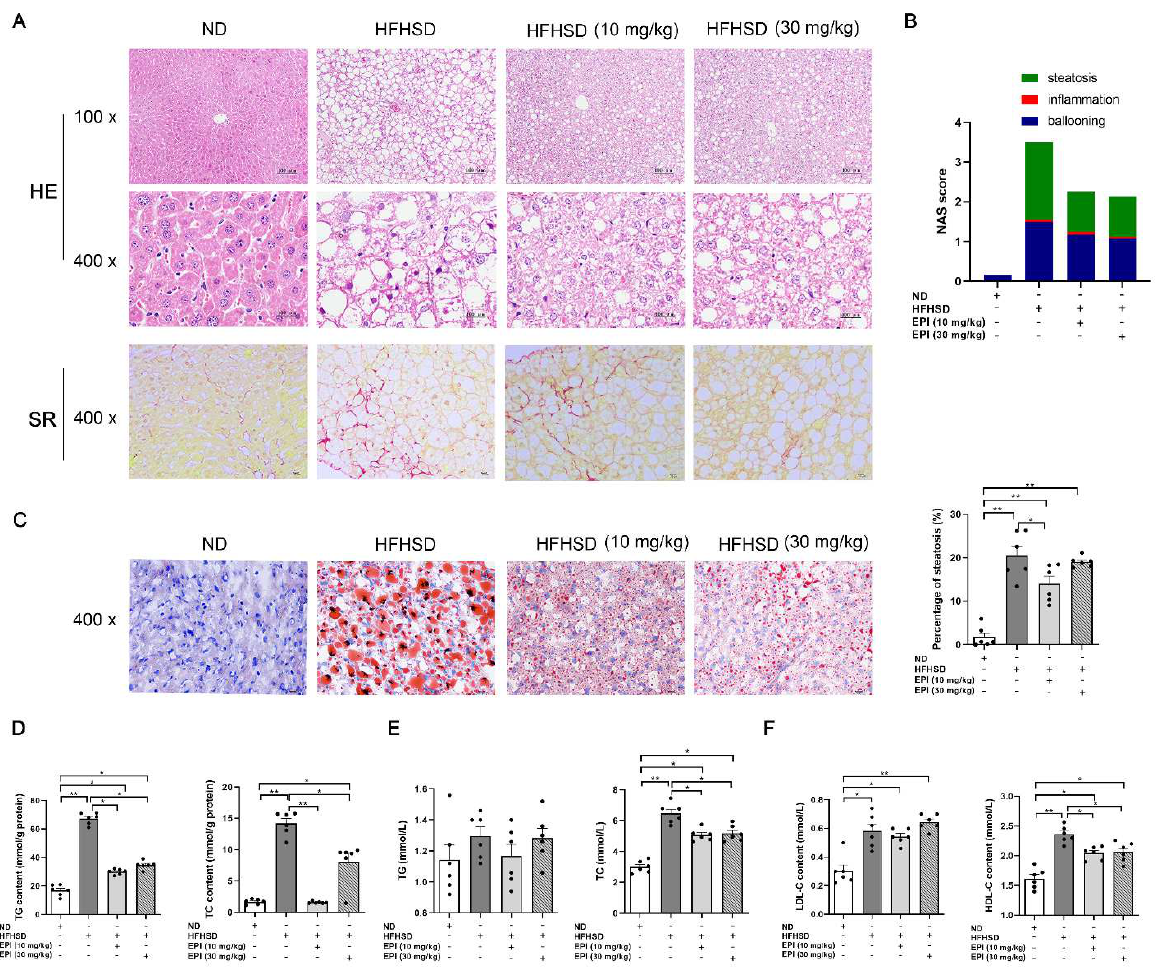
Figure 3. EPI (EPI-001) application ameliorated hepatic steatosis and decreased the levels of bio- chemical markers in HFHSD-induced mice. ( A ) Representative histologic images of liver sections (HE, hematoxylin and eosin staining, 100× and 400×, scale bar, 100 μm; SR, Sirius red staining, scale bar, 10 μm); ( B ) NAS (NASH activity score) of the HE staining sections; ( C ) Representative images of frozen liver sections stained with Oil Red O (400×, scale bar, 10 μm) and the quantitative results for Oil Red O staining; ( D ) The contents of TG (triglyceride) and TC (total cholesterol) in mouse liver; ( E ) Serum contents of TG and TC in mouse; ( F ) Serum contents of LDL-C (low-density lipo- protein-cholesterol) and HDL-C (high-density lipoprotein cholesterol) in the mouse. (mean ± SEM, * p < 0.05, ** p < 0.01, n = 6 mice per group).